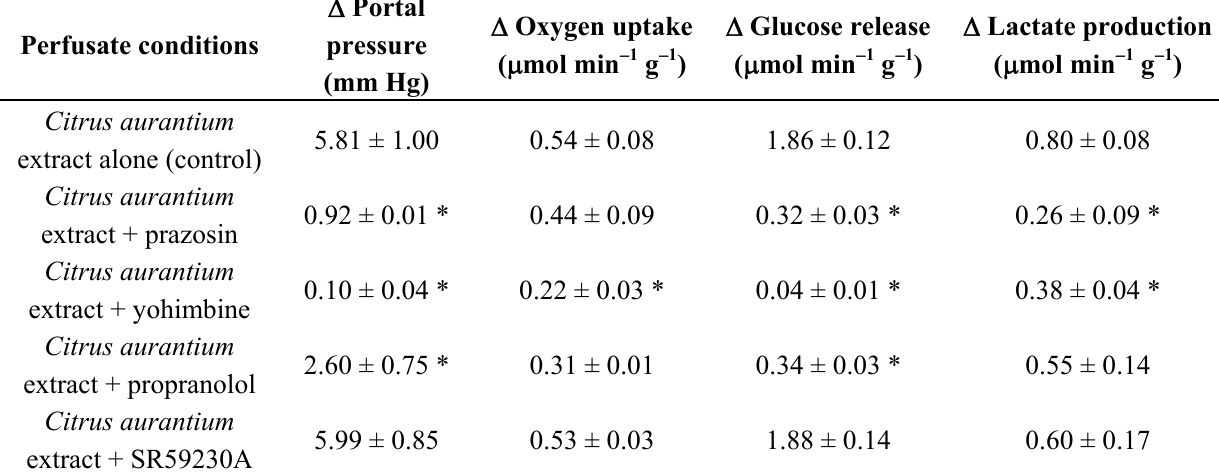
prazosin, 10 μ M; yohimbine, 100 μ M; propranolol, 50 μ M; and SR59230A, 10  M.